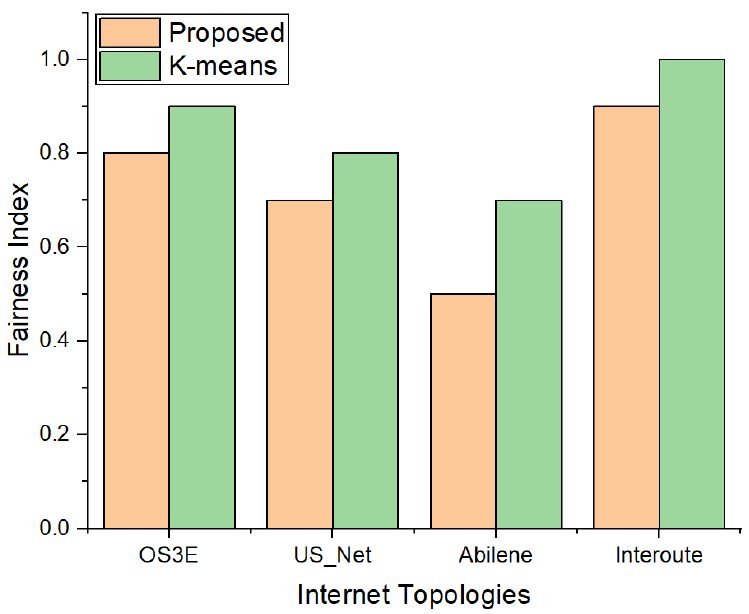
Figure 7. Comparison of the fairness index between k-means and proposed approach.